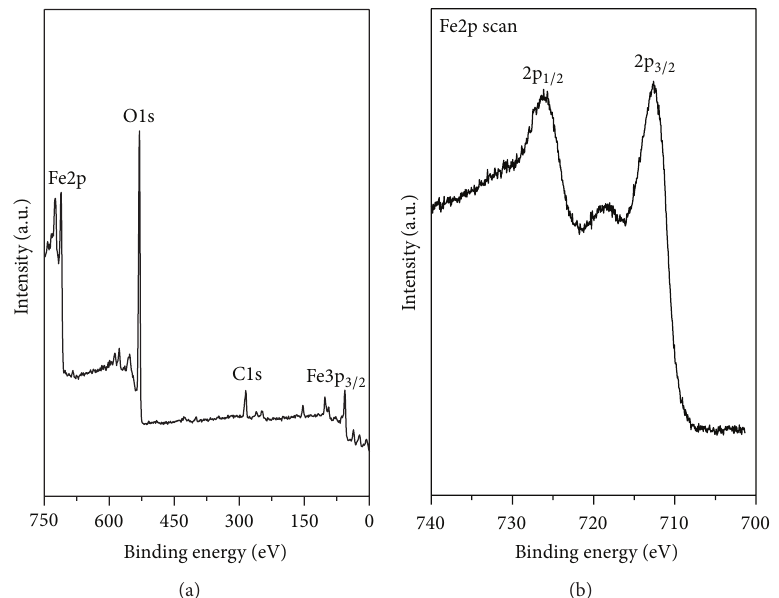
Figure 2: XPS spectra of the prepared porous 𝛾 -Fe 2 O 3 : (a) survey spectrum and (b) high-resolution image of Fe spectrum.